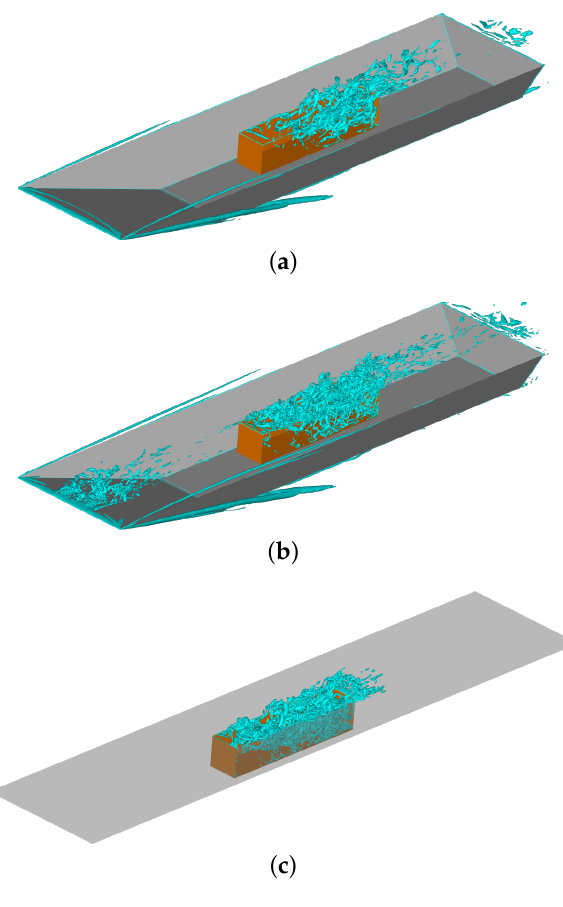
Figure 8. ( a ) Wind tunnel model, SA-DDES. The visibility of the rig’s top surface and left cavity wall is turned off. ( b ) Wind tunnel model, SA-IDDES. ( c ) Simplified geometry, SA-IDDES. The visibility of the left cavity wall is turned off, and the top surface is